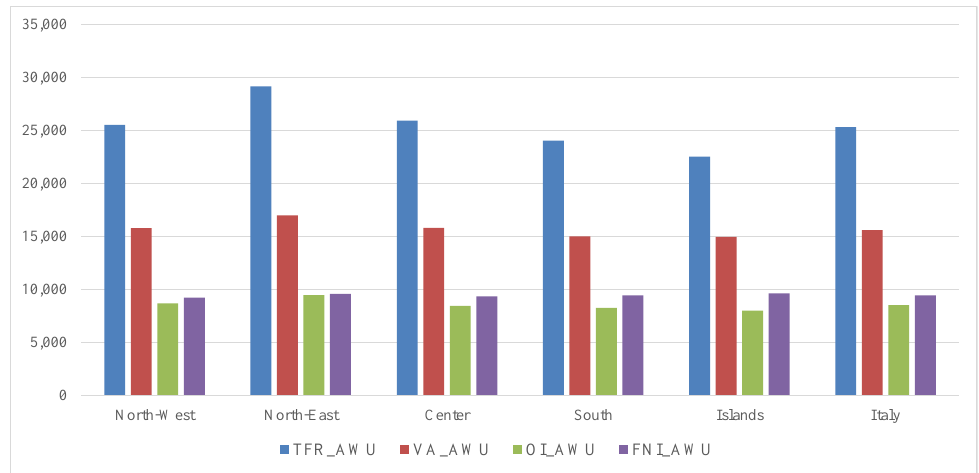
Figure 8. Economic indices of small farms by total work unit (AWU) and by district. Source: Our elaboration on FADN data, 2018 – 2020.